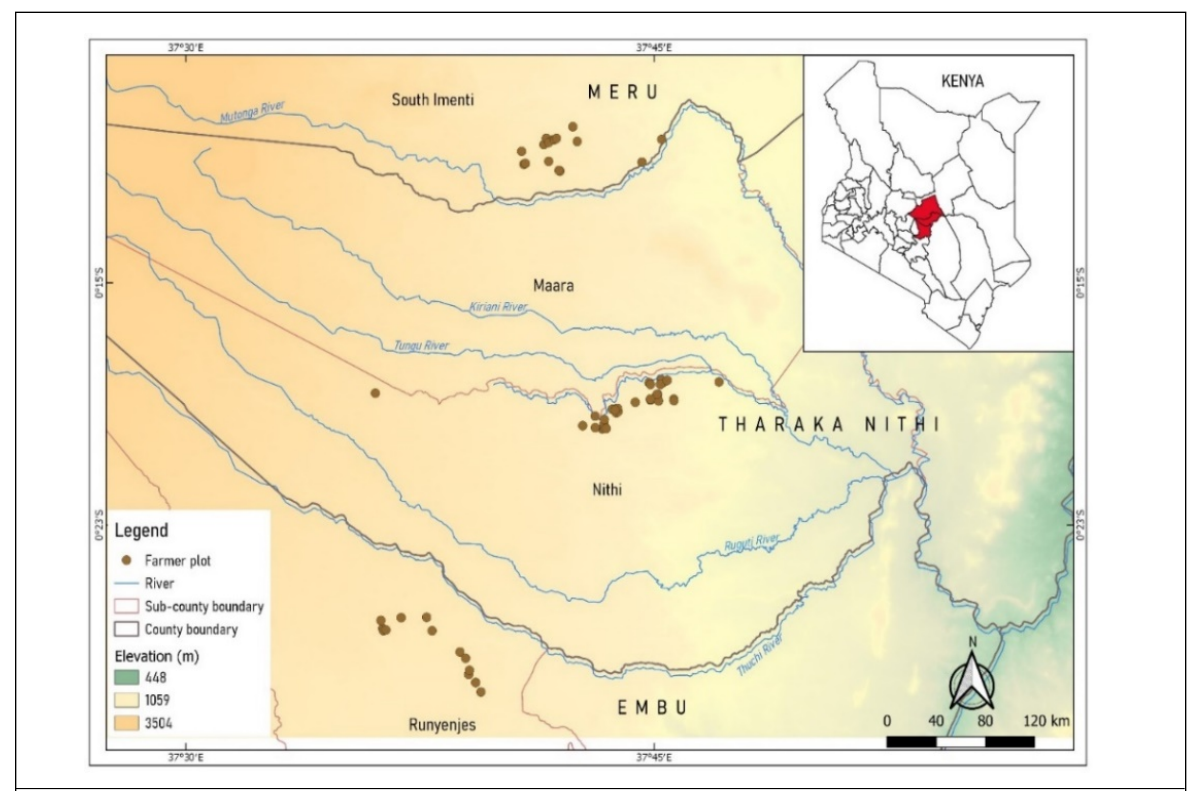
Figure 1: Location of 64 trial farms in Embu, Tharaka-Nithi and Meru counties of